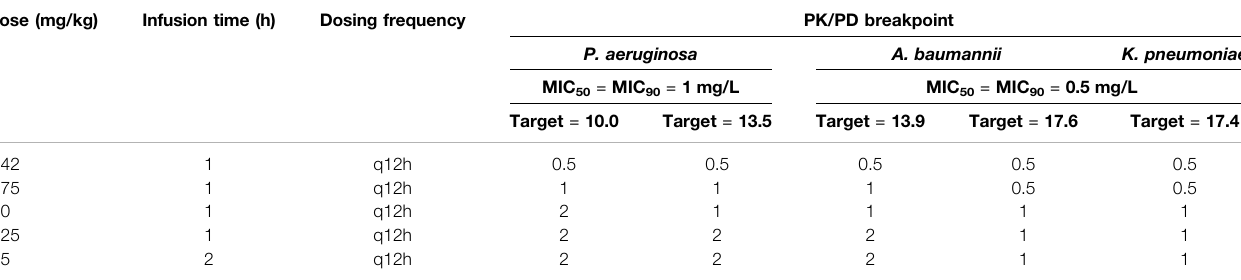
TABLE 3 | Susceptible breakpoints for isolates of P. aeruginosa , A. baumannii and K. pneumoniae based on the PK/PD of polymyxin B. Dose (mg/kg) Infusion time